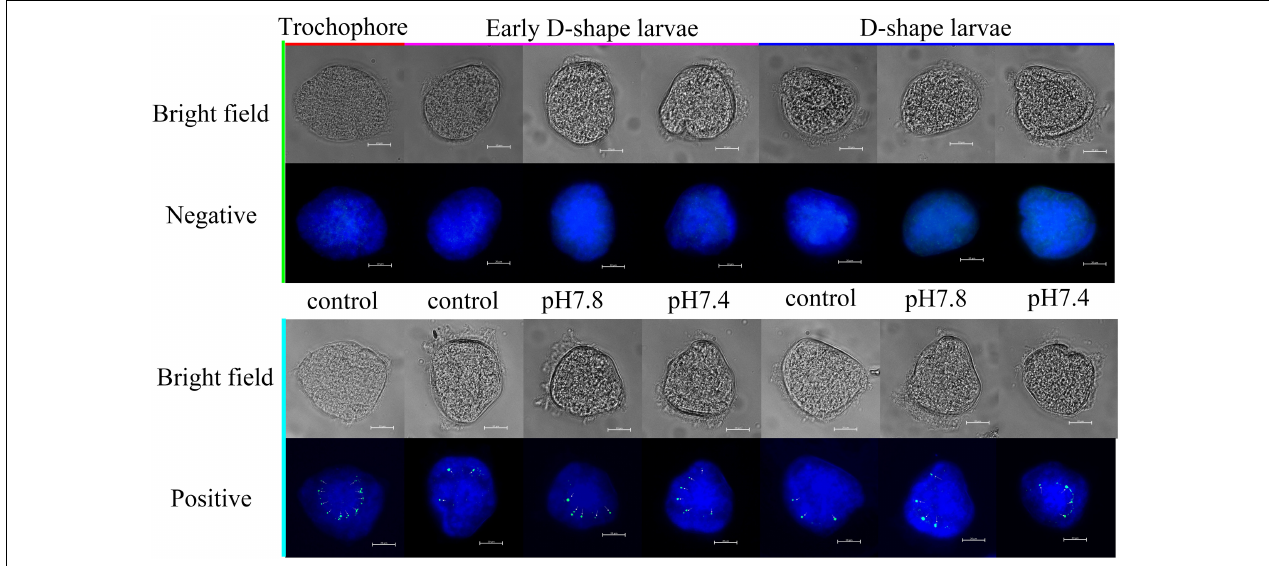
FIGURE 4 | Whole-mount immunofluorescence assay of Cg engrailed-1 expression in oyster larvae. The expression of Cg engrailed-1 in oyster larvae at trochophore, early D-shape larvae and D-shape larvae stages upon moderate (pH 7.8) and severe (pH 7.4) acidification treatments were determined by whole-mount immunofluorescence assay. Mouse negative serum was employed in the negative control group. Nucleus was stained with DAPI and shown in blue; Green point indicated the positive signal which was depicted by little white arrows.